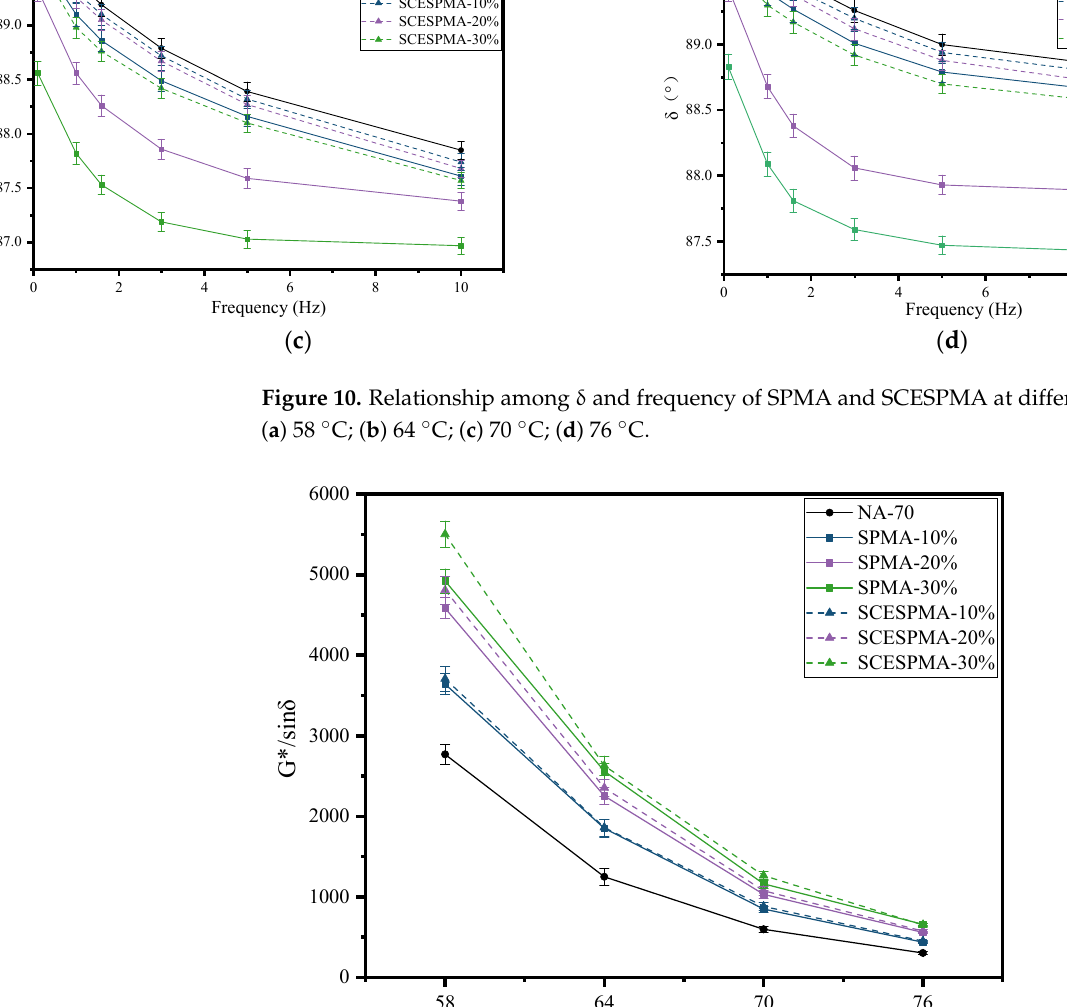
Figure 12. Continuous high-temperature PG analysis of SPMA and SCESPMA. As shown in Figure 12, the temperature T cH of continuous high-temperature PG of NA-70 increases as the contents of SP and SCESP increase. Compared with that of NA-70, the T cH of SCESPMA-10%, SCESPMA-20% and SCESPMA-30% increases by 4.49%, 6.98% and 9.49%, respectively, and the T CH of SPMA-10%, SPMA-20% and SPMA-30% increases by 4.22%, 6.21% and 8.52%, respectively. It can be found that the temperature T CH of SCESPMA is higher than that of SPMA at the same content. It is indicated that SCESP improves the high-temperature performance of NA-70, which may be related to the prismatic layer of seashell with more holes. The